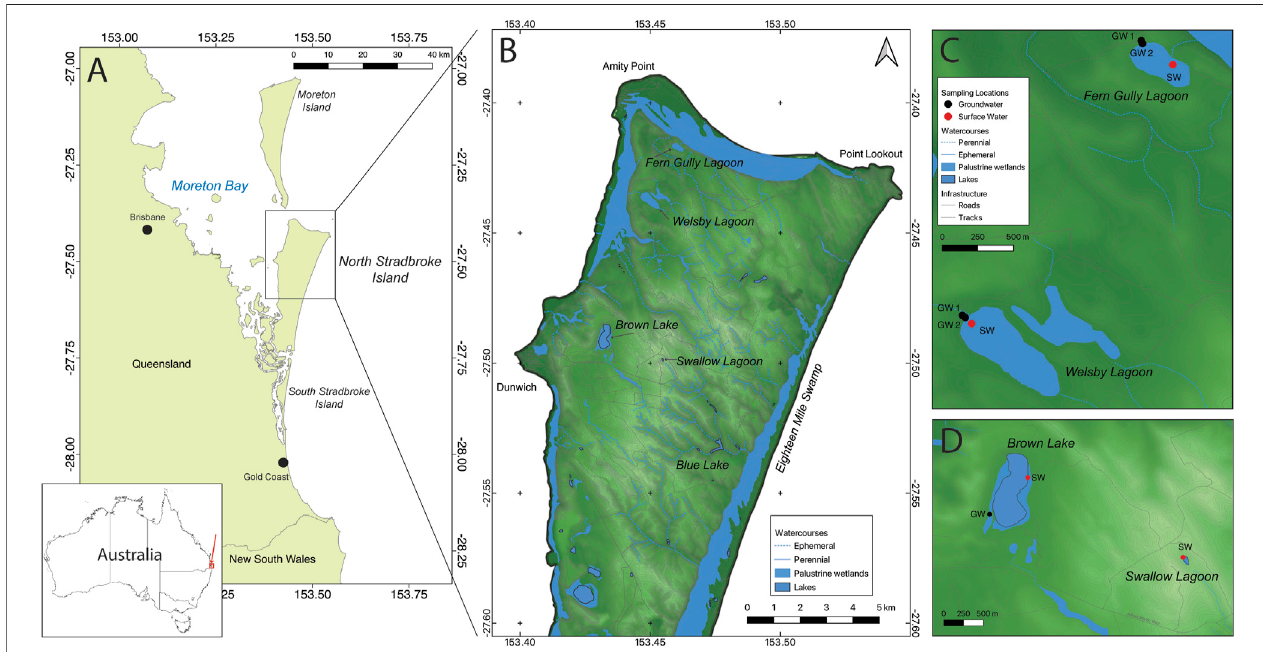
FIGURE 1 | Map of (A) Australia; (B) North Stradbroke Island (Minjerribah), indicating location of studied wetlands; enlarged maps, including sampling locations at (C) WelsbyLagoonandFernGullyLagoon;and (D) SwallowLagoonandBrownLake.Redpointsindicatesurfacewatermonitoringandsamplinglocations,blackpoints indicate groundwater monitoring and sampling locations.